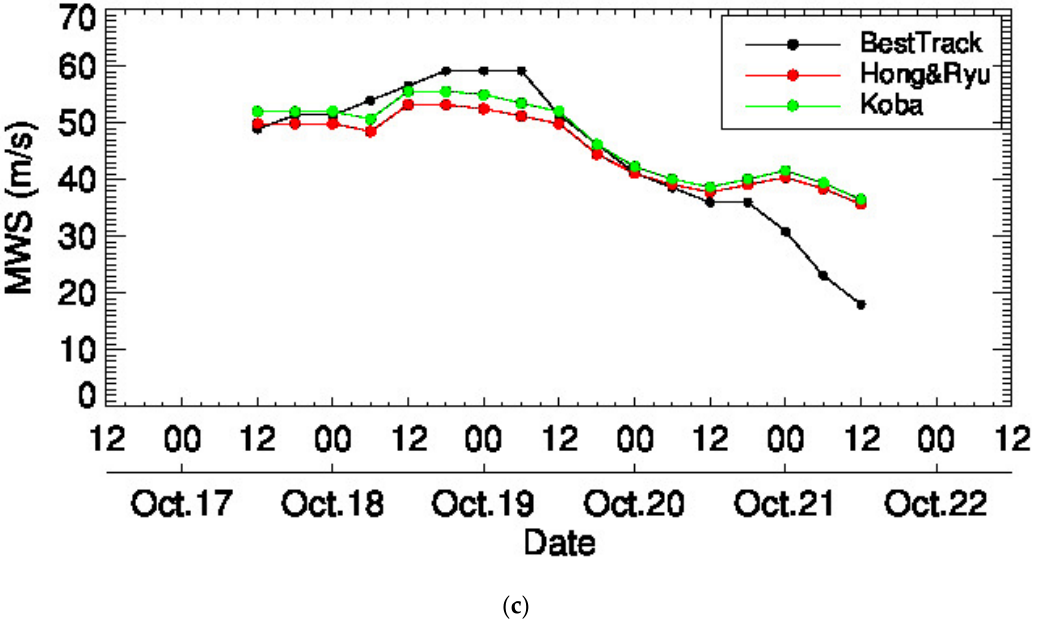
Figure 10. Time series of estimated maximum wind speeds for three typhoons: ( a ) Jebi in 2013, ( b ) Rammasun in 2014, and ( c ) Haima in 2016, derived from the best track, and two ADTs with the Koba and Hong and Ryu scales.